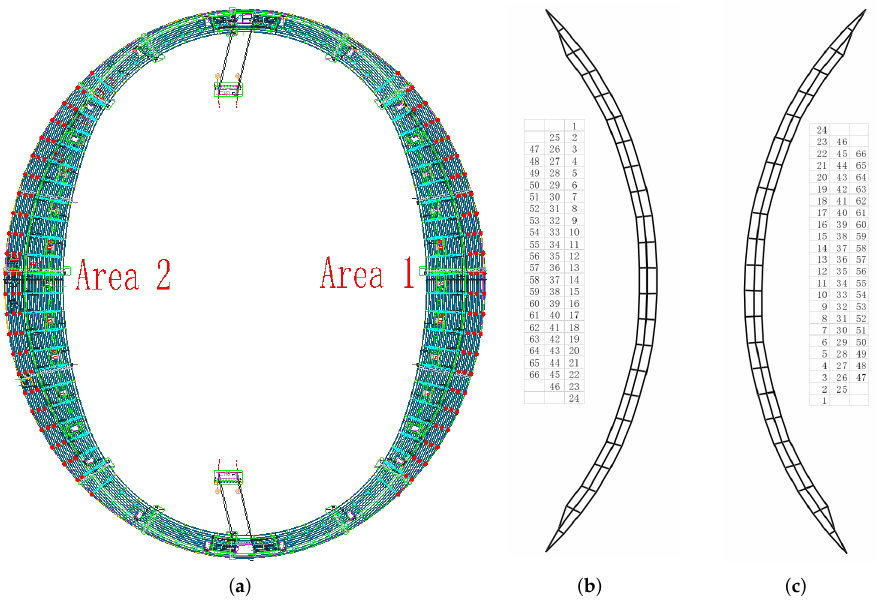
Figure 2. Area and number of dynamic characteristics measurement points. ( a ) Modal test area; ( b ) Area 1; ( c ) Area 2.